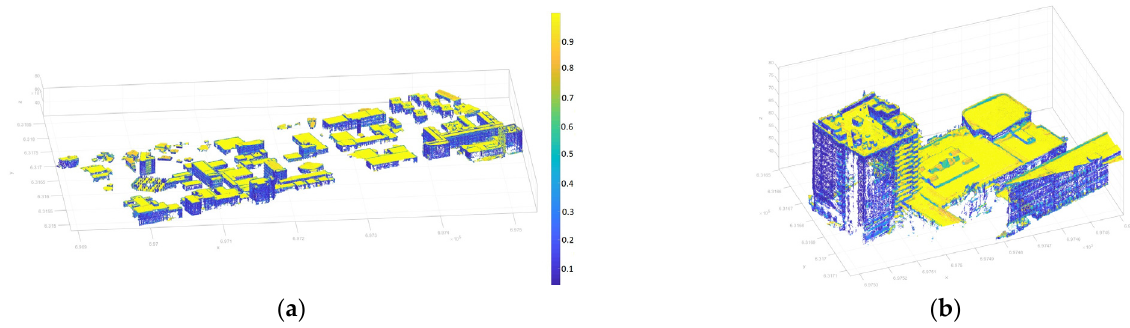
Figure 25. ( a ) The buildings’ point cloud colored based on normal vector component along the Z axis (normalZ attribute), ( b ) detail.